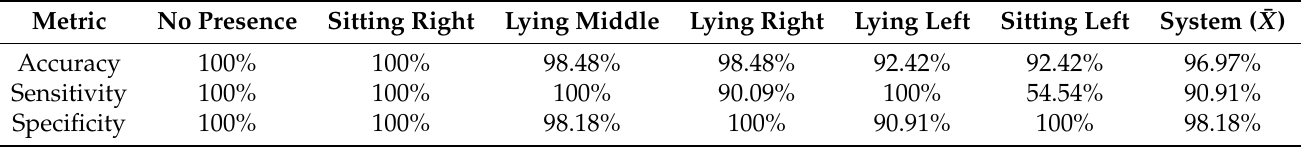
Table 6. Metrics for the multi-class confusion